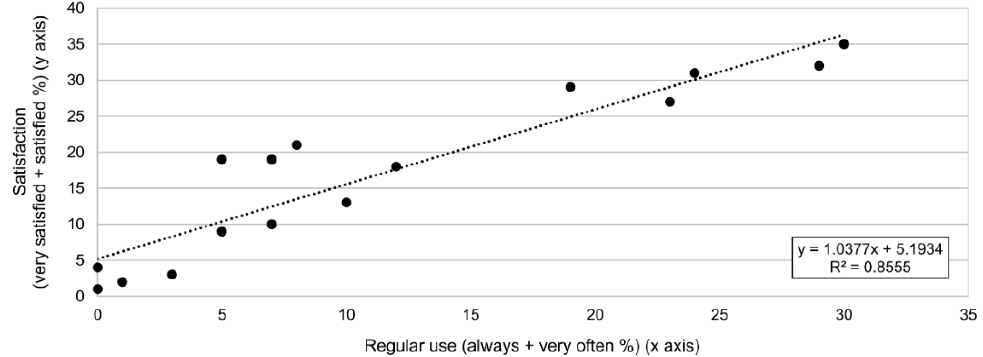
Figure 5. Scatter plot and regression li ne for ‘Regular use’ vs. ‘Satisfaction’ variables.